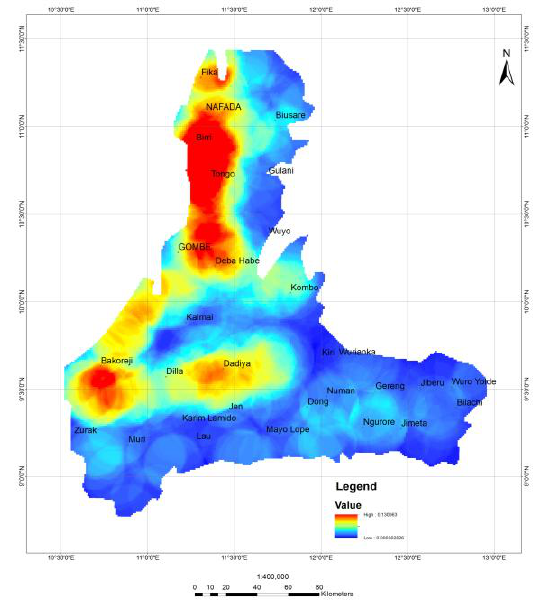
Figure 15. Lineament Density map of the Upper Benue